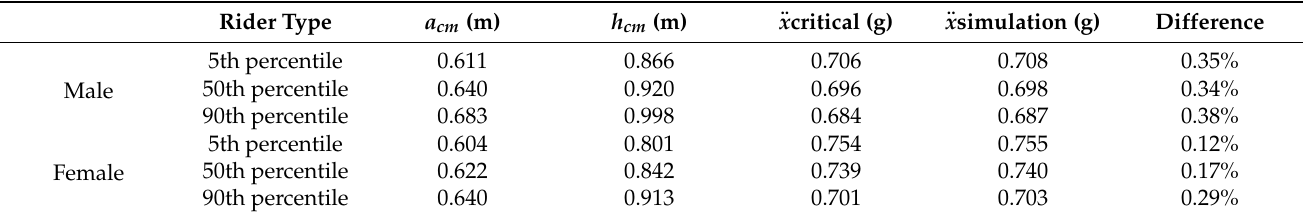
.. x ) at the point of tip-over for the varying center of mass from the Table 3. Maximum deceleration ( front axle ( a cm ) and center of mass height from the ground plane ( h cm ) [23].